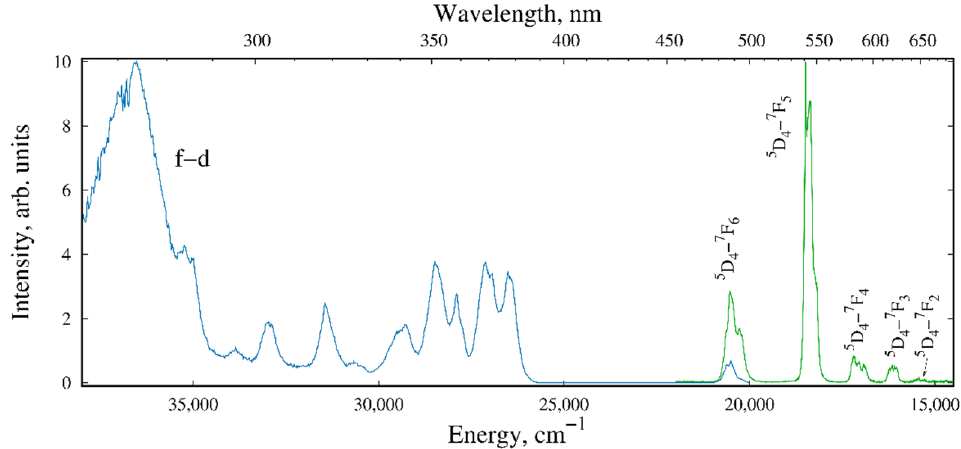
Figure 3. Excitation (blue line, λ em = 543 nm) and emission (green line, λ ex = 370 nm) spectra of 3 (solid sample, RT).